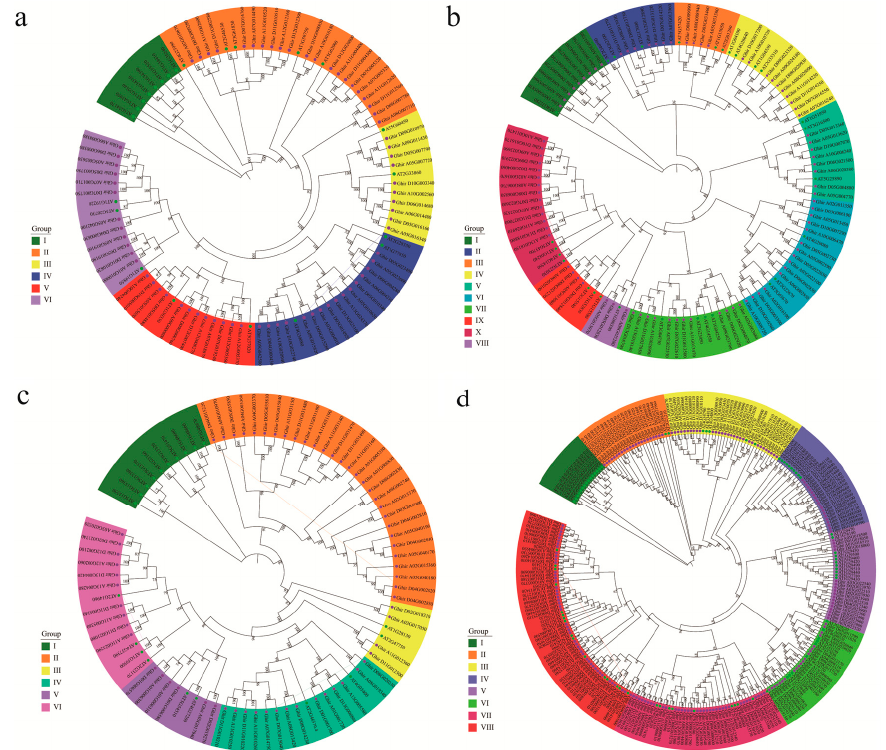
Figure 1. Phylogenetic trees of ARF ( a ), Aux/IAA ( b ), GH3 ( c ), and SAUR ( d ) family genes